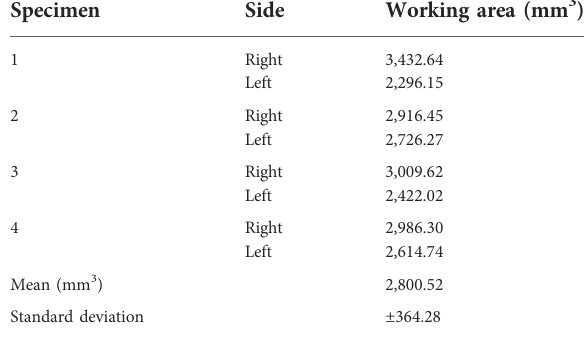
TABLE 1 Quantitative analysis of the available “ working area ” within the posterior and middle cranial fossa, obtained after complete bone removal through the endoscopic transorbital